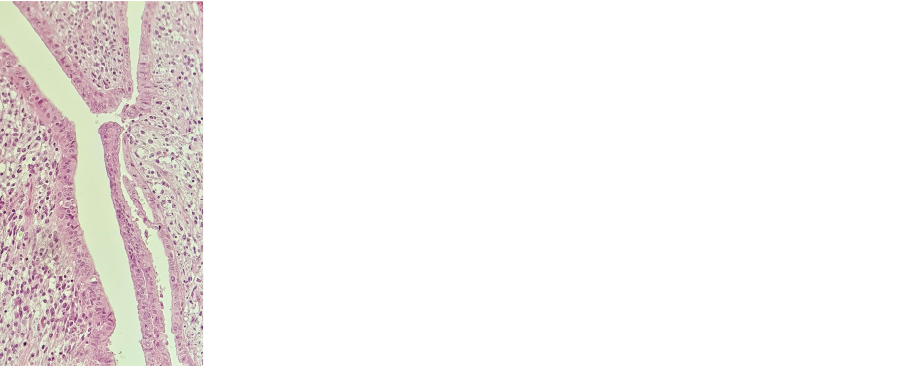
Figure 2. Slit-like space lined by benign epithelium with periductal condensation of atypical stromal cells (H&E stain, ob. x200).